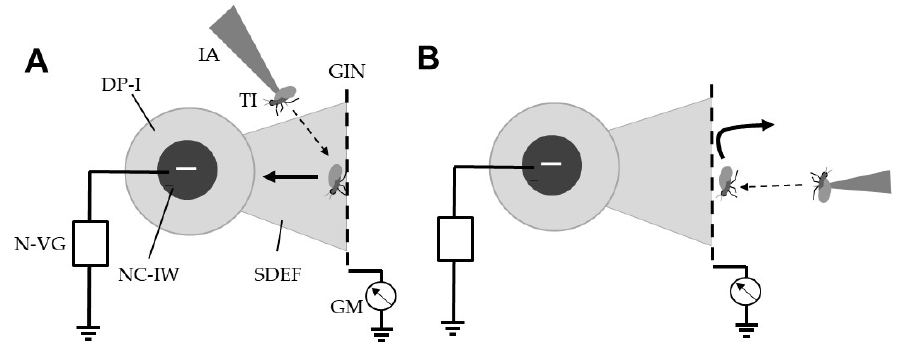
Figure 7. Schematic representation of insect capture ( A ) and repulsion ( B ) after insect placement on the electric field-side and outside surface of the grounded metal net, respectively. Solid straight and curved arrows indicate the paths of an insect transferred along the dotted line from an insect aspirator (IA). Abbreviations are provided in Figure 2.